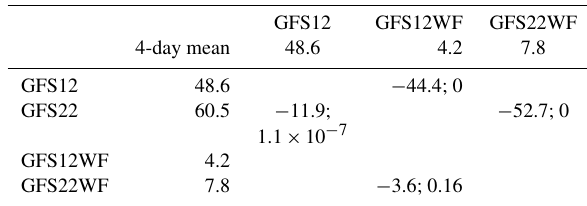
Table 7. As in Table 6, but for GFS runs.